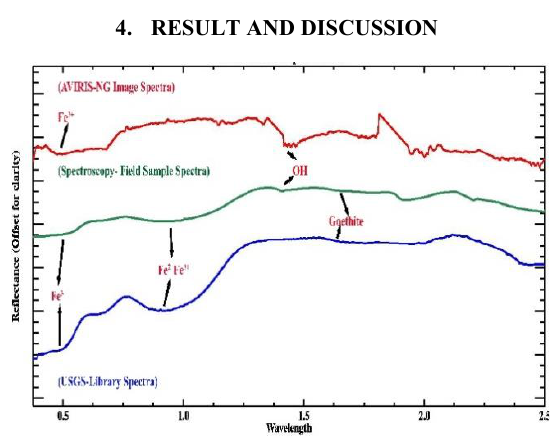
Figure 2:Spectral features of goethite minerals.